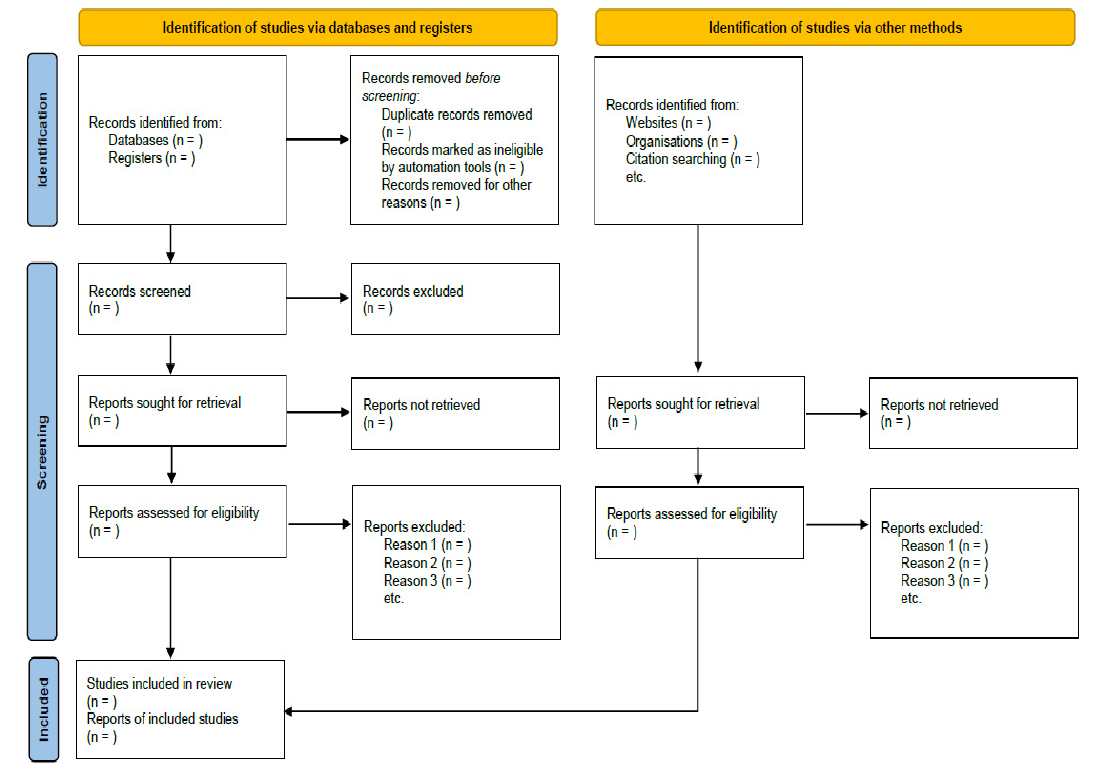
Figure 1. PRISMA flow diagram of the literature screening and selection process.